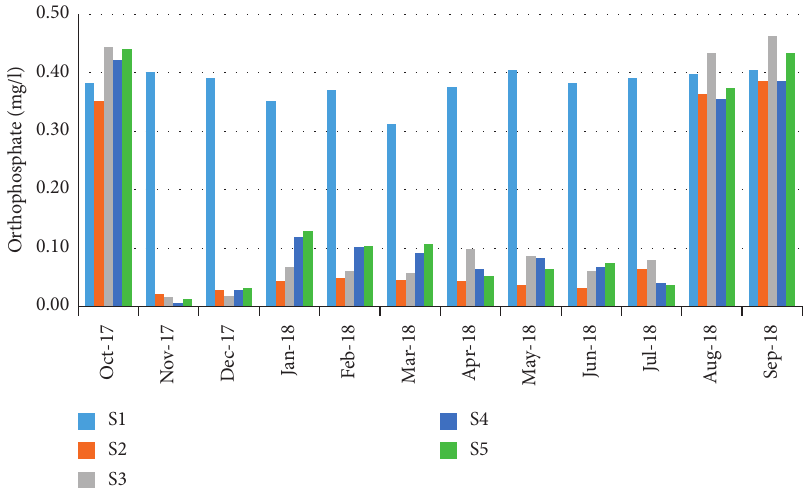
Figure 14: Spatial-temporal variation of orthophosphate in the Zegzel